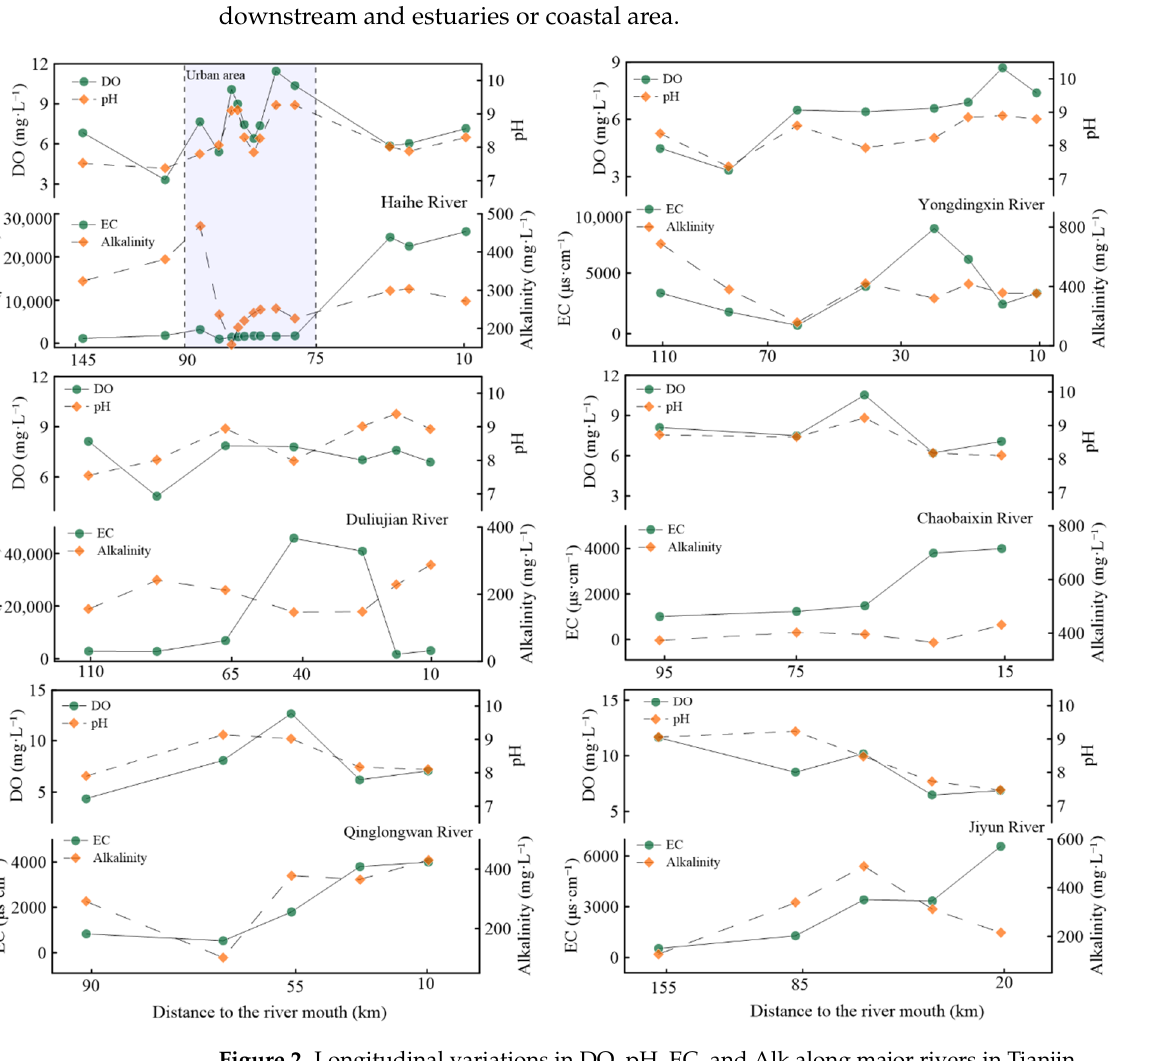
Figure 2. Longitudinal variations in DO, pH, EC, and Alk along major rivers in Tianjin.